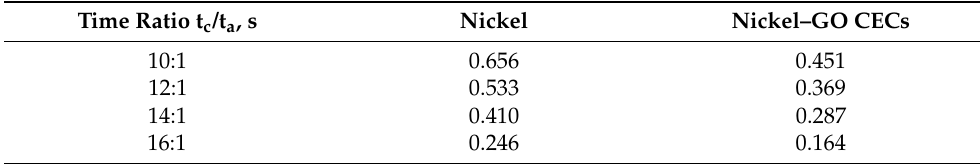
Table 2. Corrosion rate of nickel-based coatings,